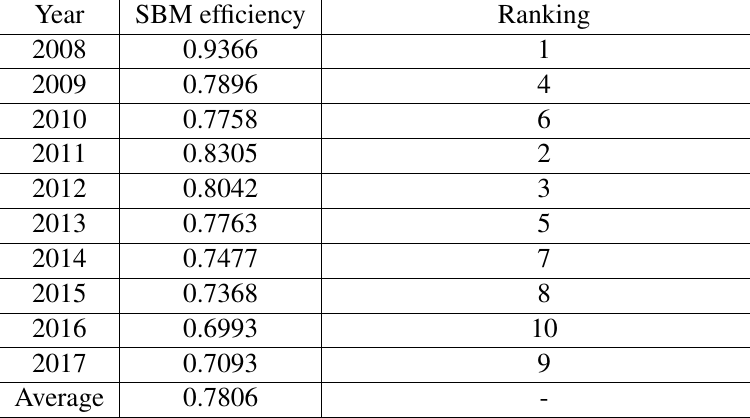
Table 2 Average efficiency and ranking of manufacturing